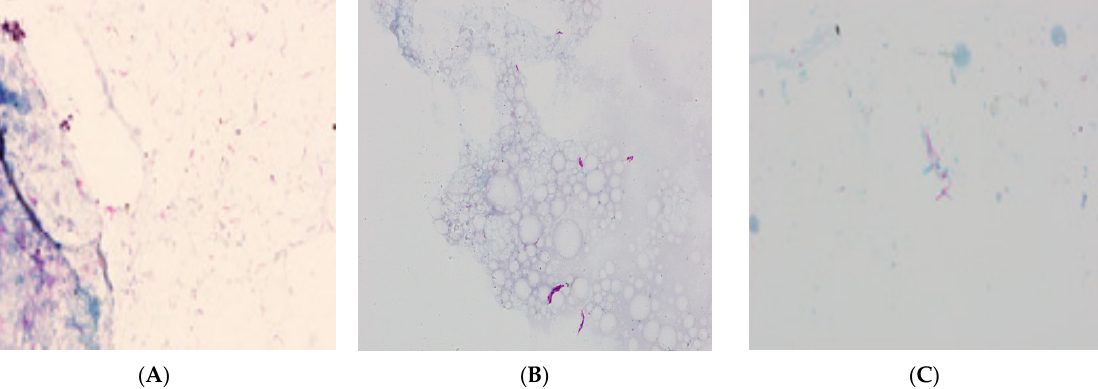
Figure 2. Acid-fast bacilli visible after Ziehl–Neelsen staining; ( A )—sputum (Patient 1); ( B )—urine (Patient 2); ( C )—sputum (Patient 2).